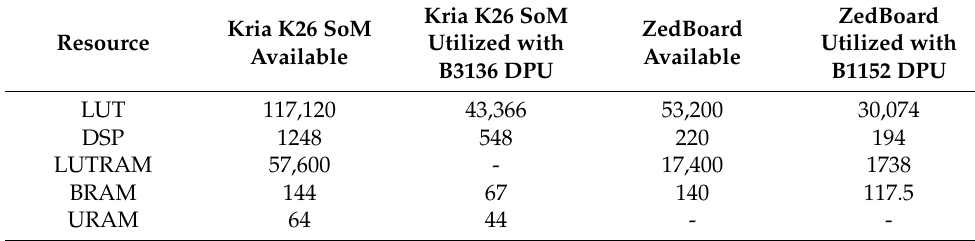
Table 2. PL Resources in Kria vs